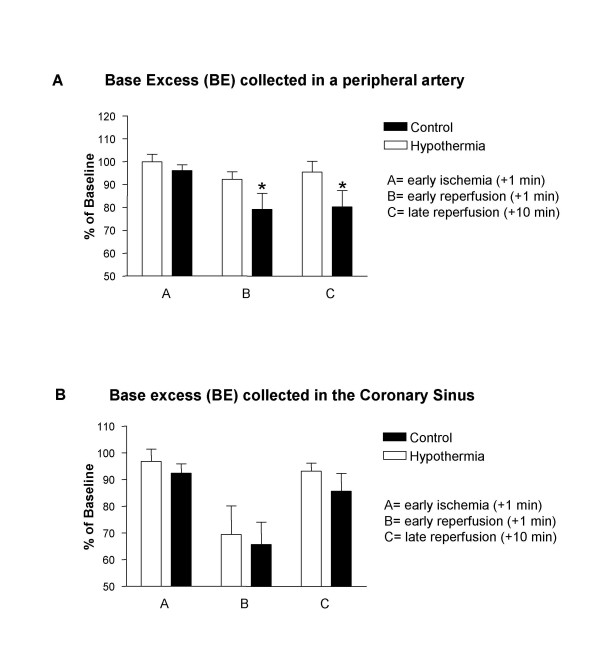
Base excess (BE) collected in a peripheral artery and the Coronary Sinus. Base excess (BE) was measured in a peripheral artery (A) and in the Coronary Sinus (CS), (B). There was no difference between normothermic (n = 8) and hypothermic pigs at baseline. During early (+1 minute) and late (+10 minutes) reperfusion there was a significant reduction in BE in the normothermic group in samples from the peripheral artery (A). In samples from the CS, there was a marked reduction in BE in both groups during early reperfusion, which then nearly returned back to baseline at late reperfusion with no difference between the groups (B).